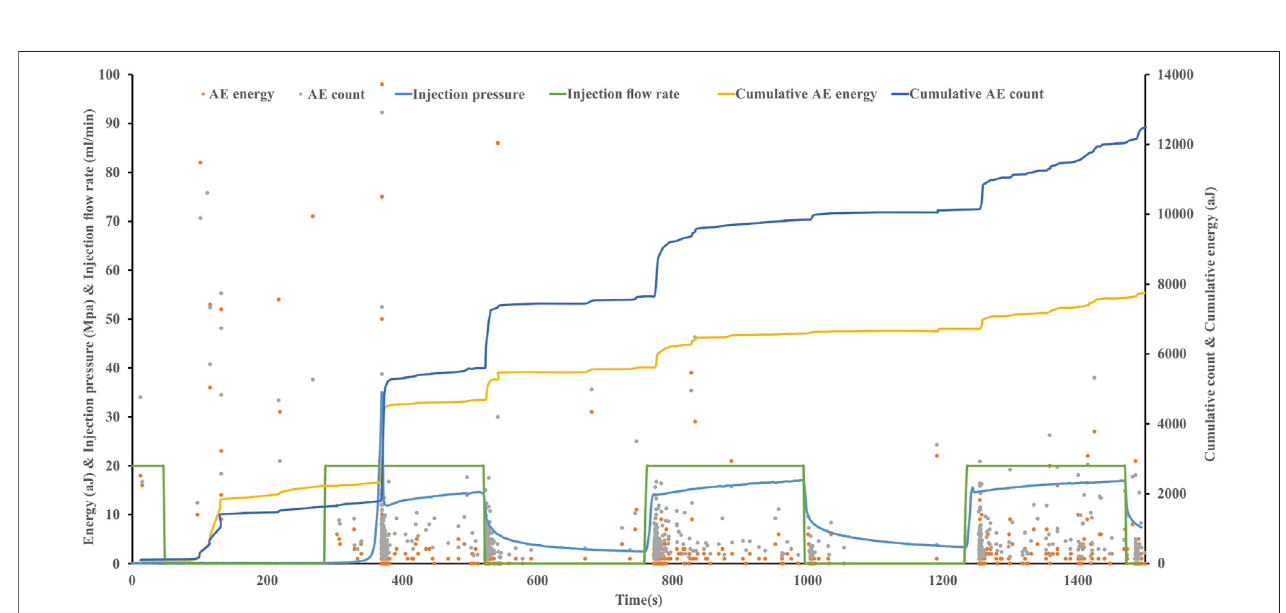
FIGURE 6 | Result of the injection pressure and AE energy and count of HDR400-4.